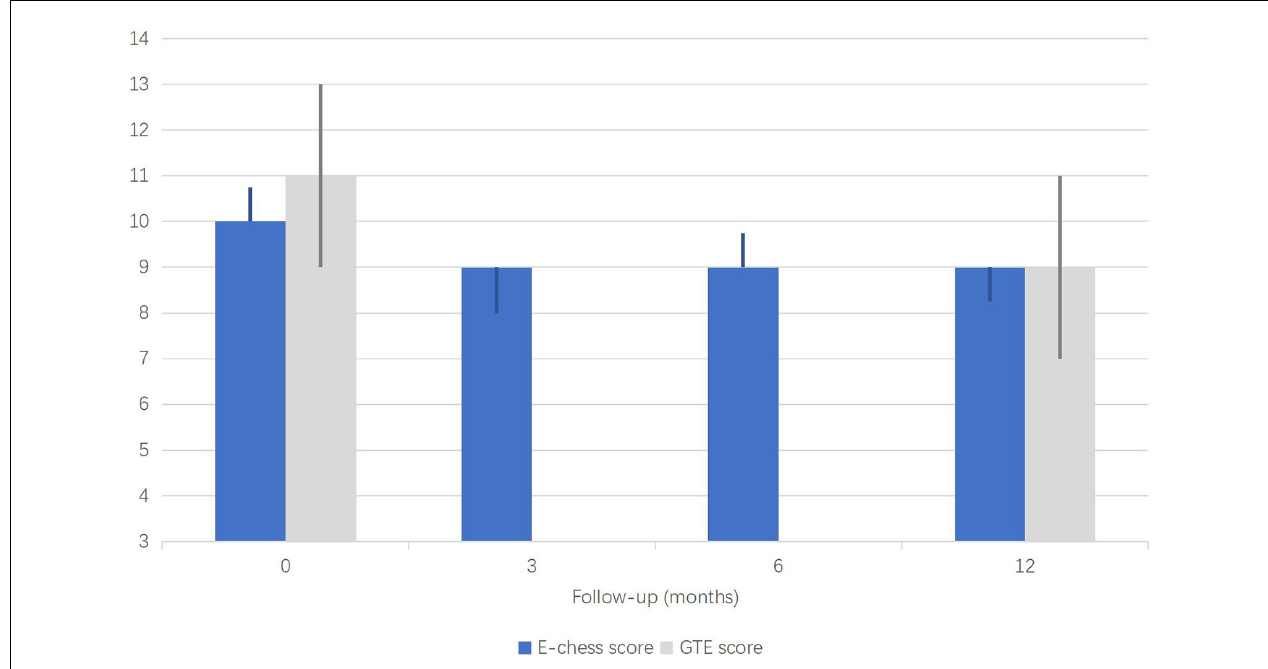
FIGURE 3 | Median E-chess score and GTE score (median, interquartile